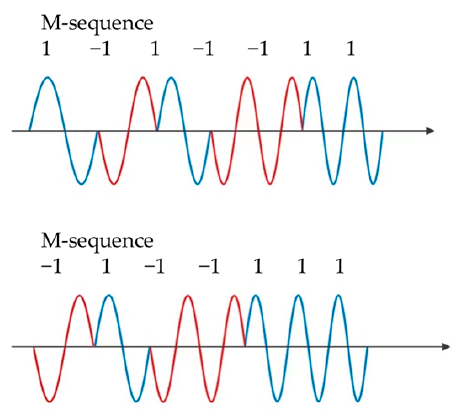
Figure 20. Two LFM signal examples coded by the same M-sequence but start from different se- quence indexes.